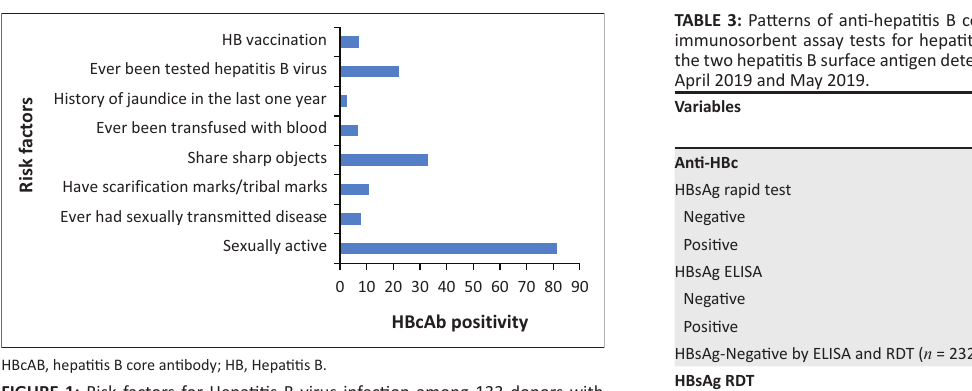
FIGURE 1: Risk factors for Hepatitis B virus infection among 133 donors with positive anti-hepatitis B core protein or antigen in Ibadan, Nigeria, between April 2019 and May 2019.